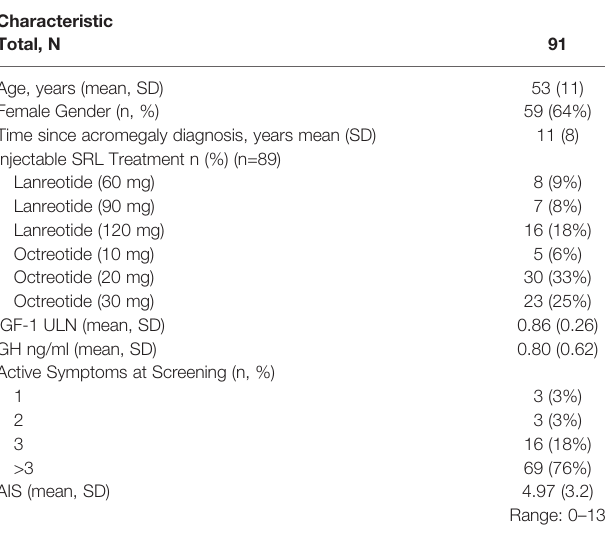
TABLE 1 | Patient